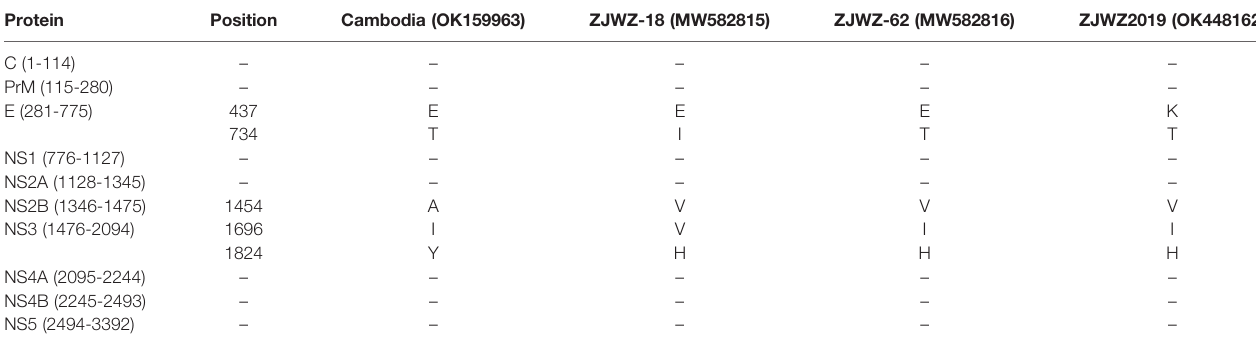
TABLE 2 | Comparison of amino acid differences in proteins in 4 DENV-1 strains. Protein